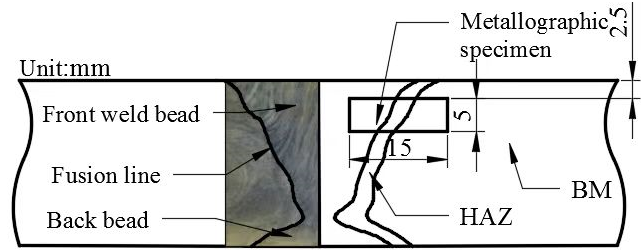
Figure 3. Sampling diagram of metallographic specimen of welded joint .